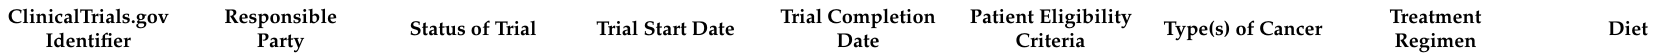
ClinicalTrials.gov